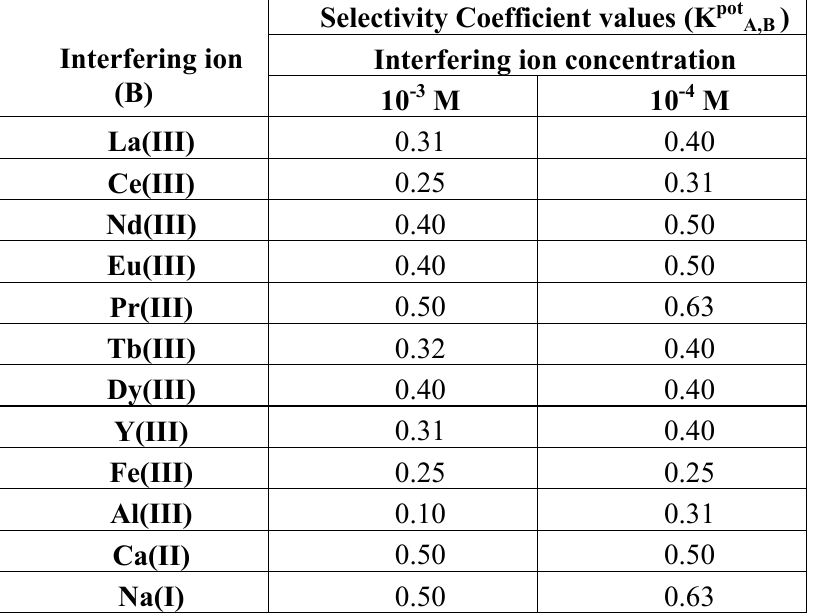
Table 2. Selectivity coefficient values for Sm (III) selective electrode based on SnBP as calculated by FIM